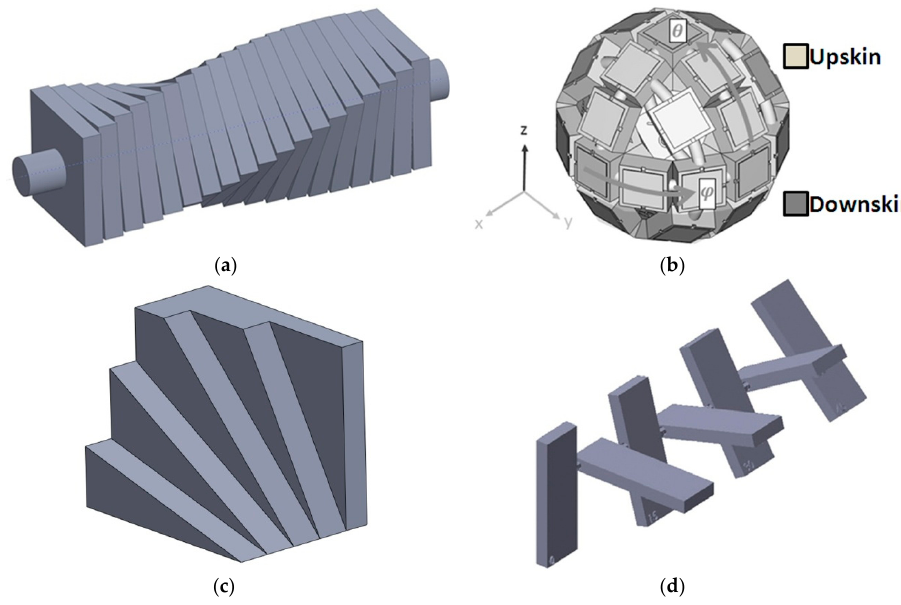
Figure 1. Test artifacts: ( a ) truncheon; ( b ) faceted sphere [26]; ( c ) specimen with sloped surfaces; ( d ) Standard Test Artifact (STAR) [14,26].